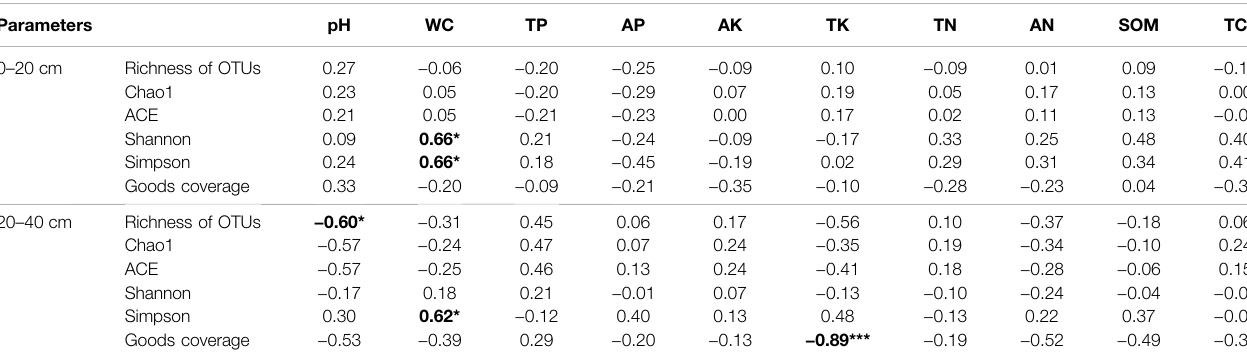
FIGURE4| Redundancy analysis(RDA)based onthe bacterial community compositionand soil characteristics intopsoil (A) and subsoil (B) amongdifferentsites. The red arrows represent soil physicochemical properties. Arrow length indicates the strength of correlation with a given ordination axis. The circles represent soil samples from different sites. The diamonds represent the major soil bacteria phylum. Note: Site abbreviations are de fi ned in Figure 1 . Soil physicochemical property abbreviations are de fi ned in Table 1 .